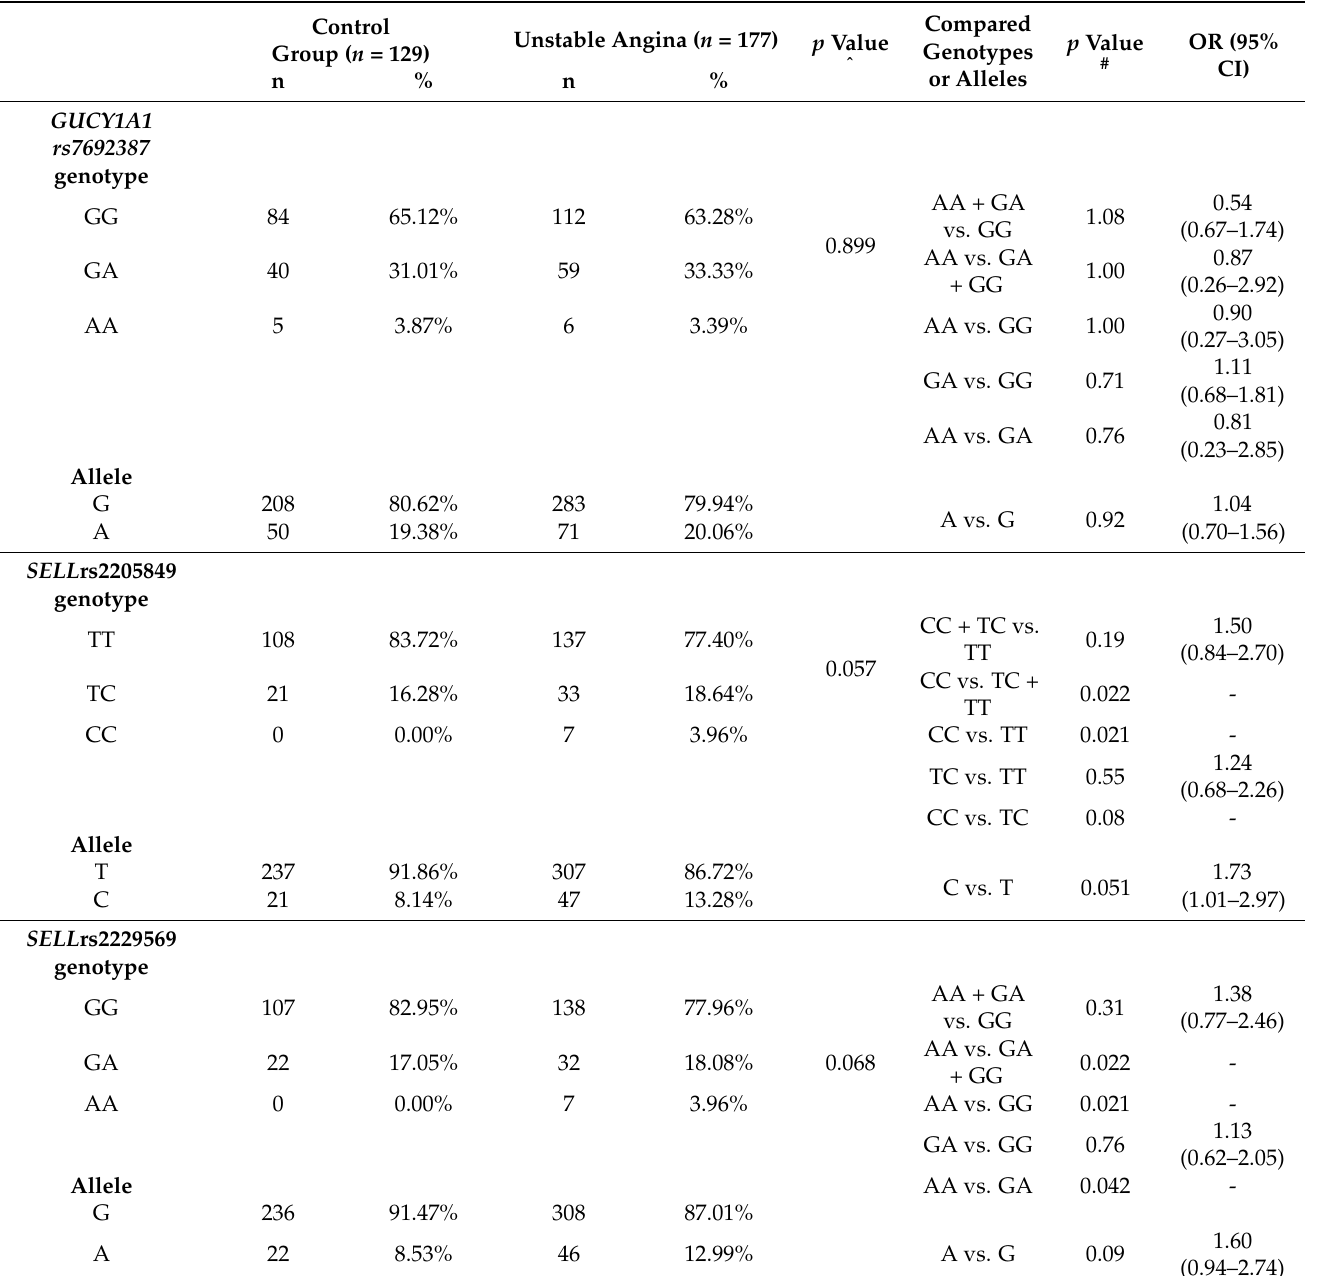
Table 4. Distribution of GUCY1A1 rs7692387, SELL rs2205849 and rs2229569 genotypes and alleles in UA patients and controls in the ≥ 55 years